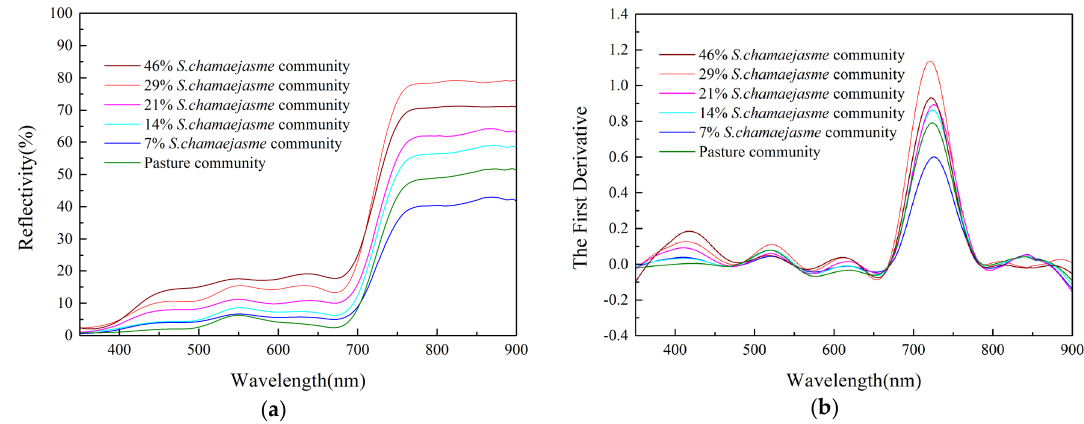
Figure 7. Reflection spectra ( a ) and the first-order differential spectra ( b ) of the S. chamaejasme communities with different coverage and pasture community.